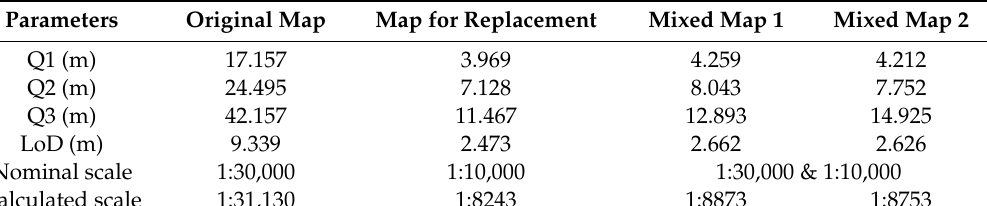
Table 6. Parameters for maps in Figure 12.